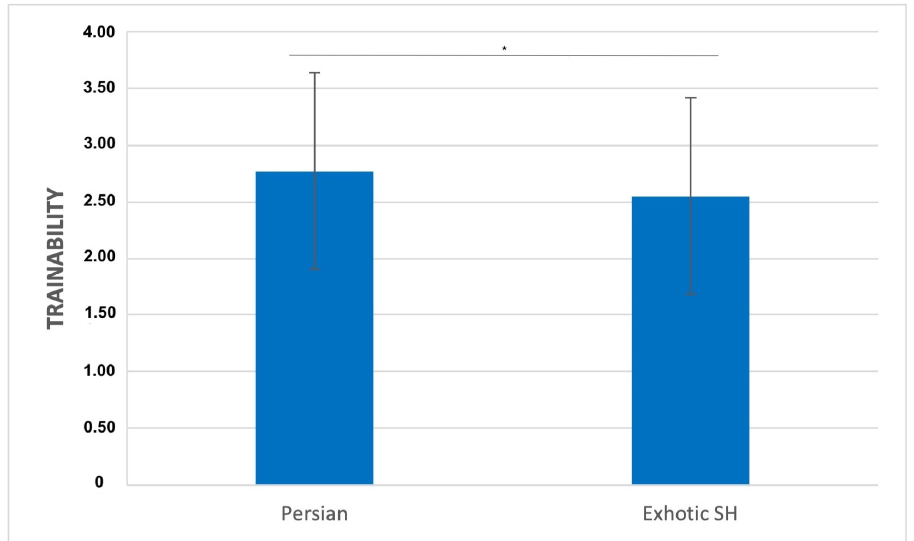
Figure 7. Comparison of Fe-BARQ mean scores for trainability between Persian and exotic shorthair. * p ≤ 0.05.